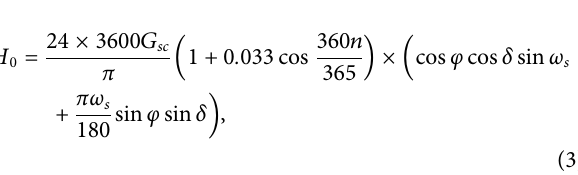
Frontiers in Mechanical Engineering |